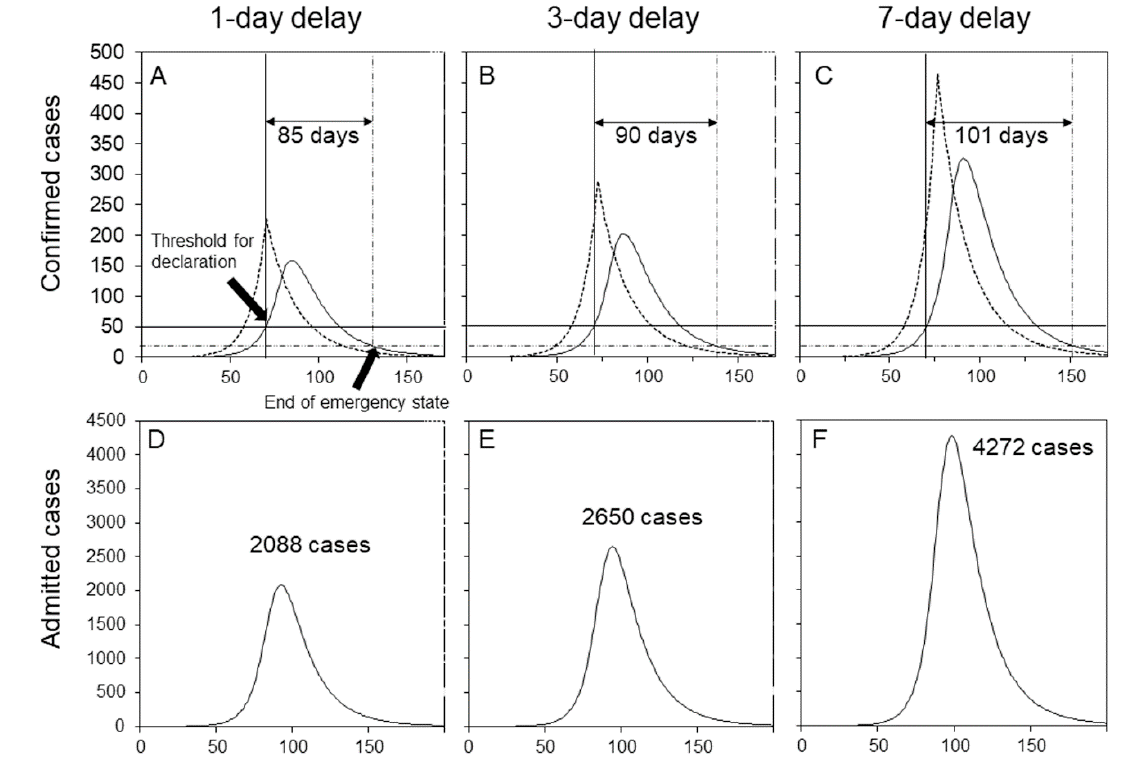
Figure 3. Intervention delay and scale of damage of the outbreak. ( A – C ) Dotted curves represent the number of cases by the date of infection (i.e., incidence of infection). Solid curves represent the number of cases by the date of reporting. The time point at which the solid line crosses the vertical and horizontal lines is when the threshold, that is, 2.5 per 100,000 people, is satisfied. The time point at which the vertical and horizontal lines cross is when the daily incidence is below 0.5 per 100,000. ( A , D ) One day after the threshold. ( B , E ) Three days after the threshold. ( C , F ) Seven days after the threshold.